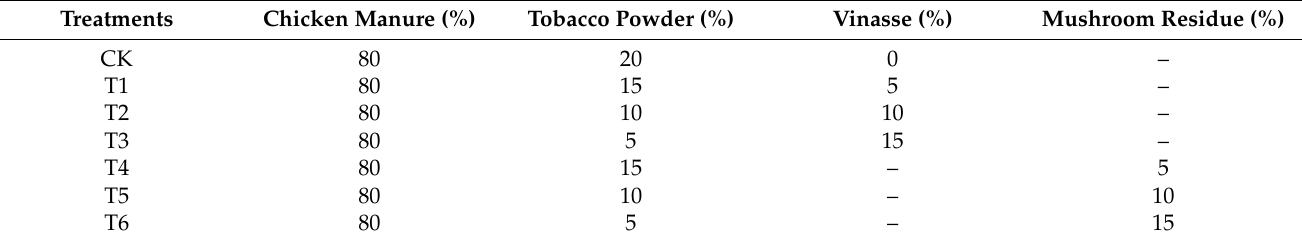
Table 2. Application rate of diverse agents in different